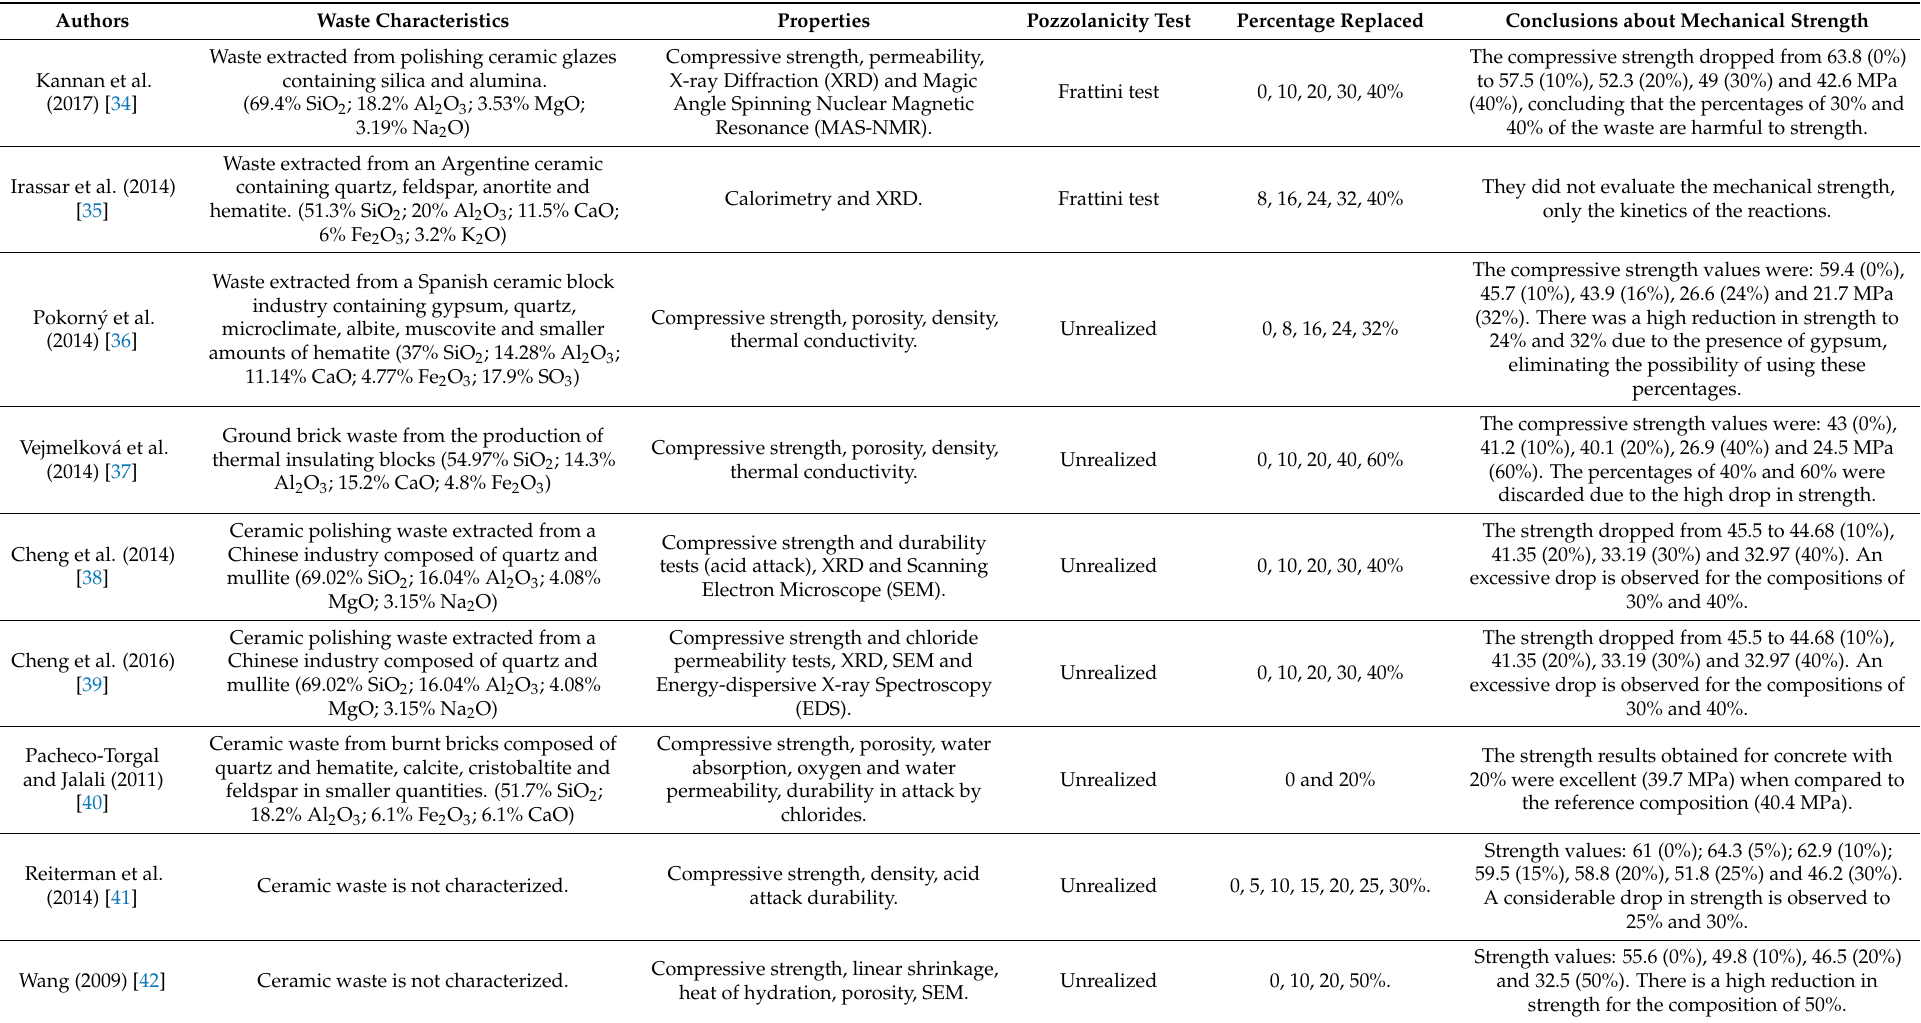
Table 1. Clay ceramic waste applied as